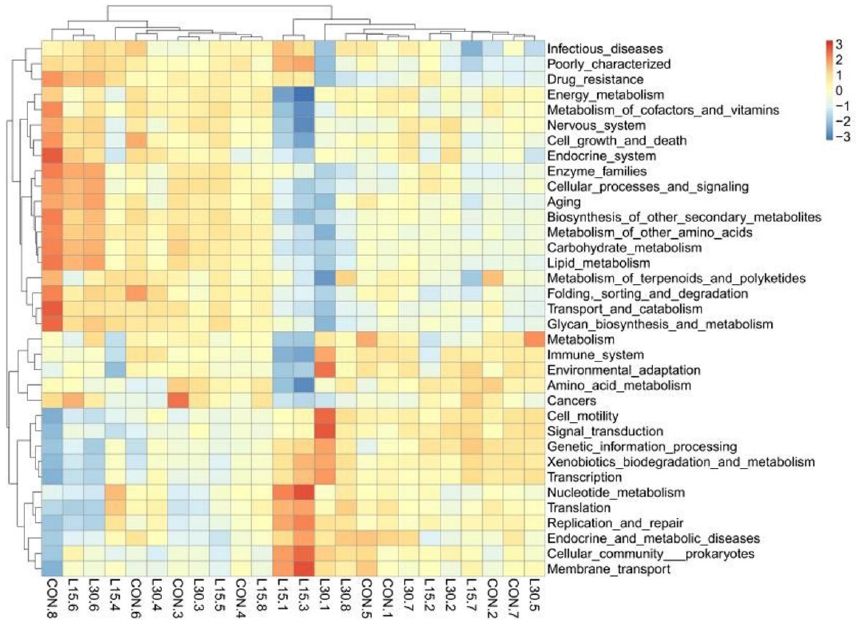
Figure 4. Cluster heatmap of the relative abundance of fecal microorganisms in the functional analysis via Tax4fun. CON, 0% FHTR silage in the diet; L15, 15% FHTR in the diet; L30, 30% FHTR in the